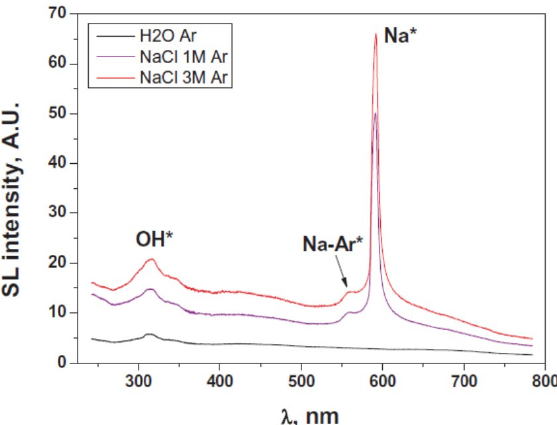
Figure 35. Measured MBSL spectra under Ar flow, in water and in 1 M and 3 M NaCl aqueous solutions (362 kHz, 43 W, 10 °C) [78]. Copyright 2019, with permission from Elsevier.